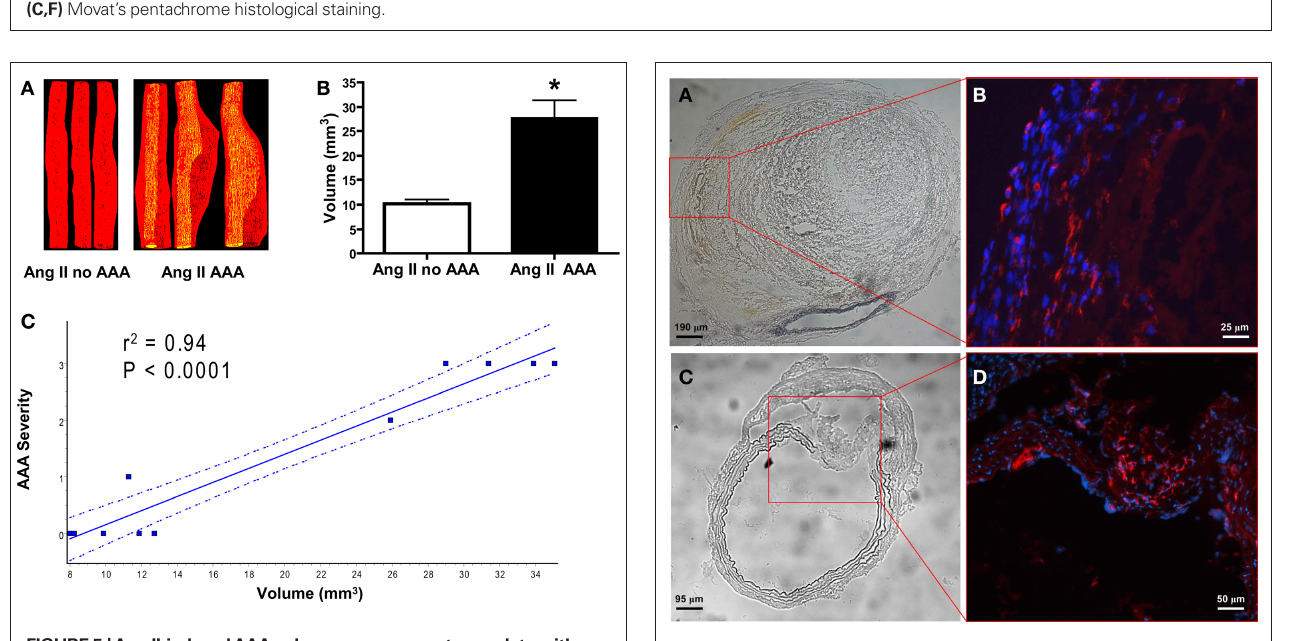
FIguRE 6 | Macrophages are major inflammatory cells in aneurysmal tissue. Phase contrast images of a severely remodeled AAA (A) and one with extensive elastic layer damage (C) . Enhanced images from the boxed area show predominant CD68 + macrophages in the adventitia (B) and macrophage infiltration at the site of elastic media break down (D) . The percentage of CD68 + macrophages (relative to DAPI-stained cells) is 42% in the boxed area (C,D) where the elastic media shows evidence of breakdown and only 3% in the remaining